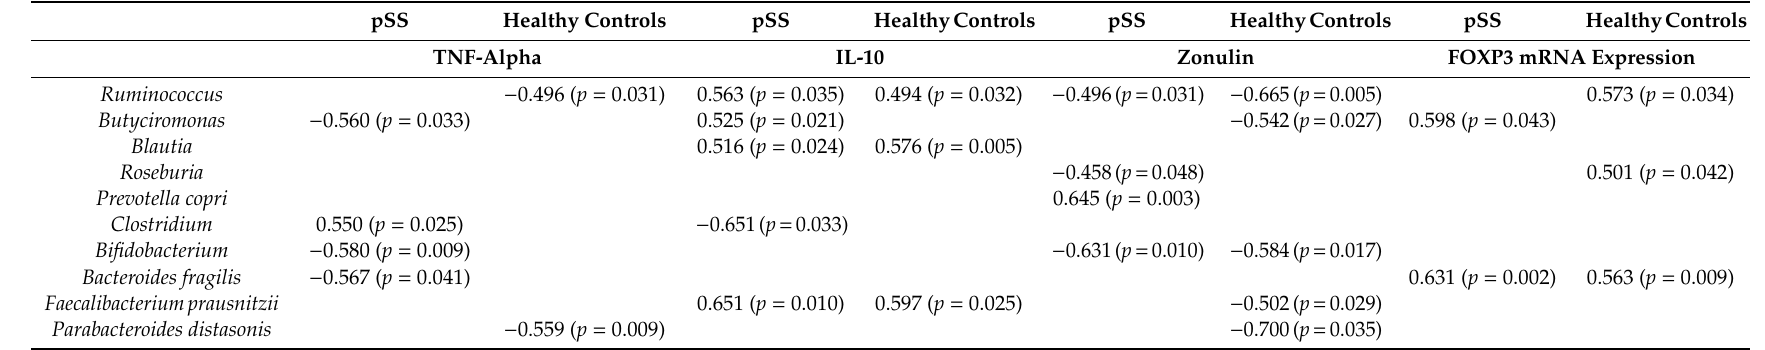
Table 3. Correlations between gut microbiota composition and serum levels of TNF-alpha, IL-10, zonulin and FOXP3 mRNA expression in the study